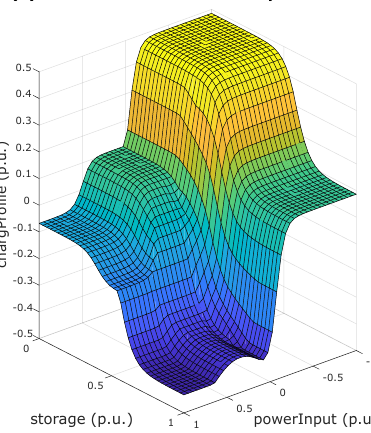
Figure 14. Comparison of train energy consumption/regeneration